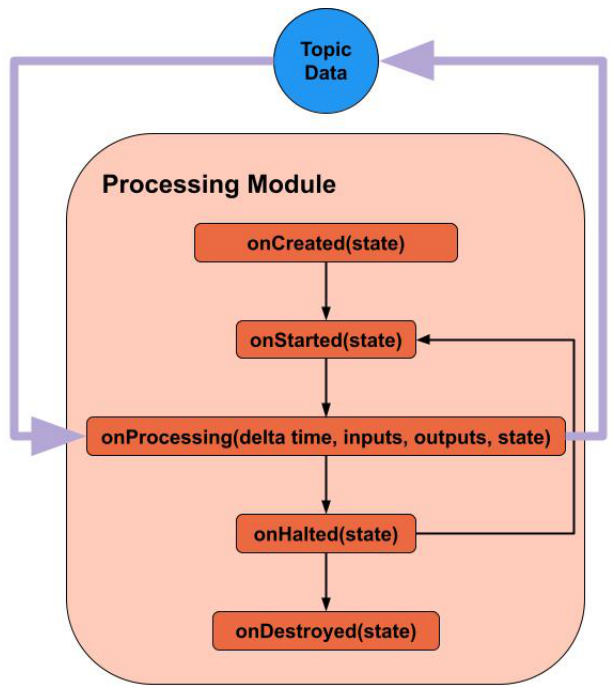
Figure 3. Processing Module life cycle overview. External dependencies are either accessed via the internal state (if defined globally for all PMs) or through the code of the life cycle callbacks